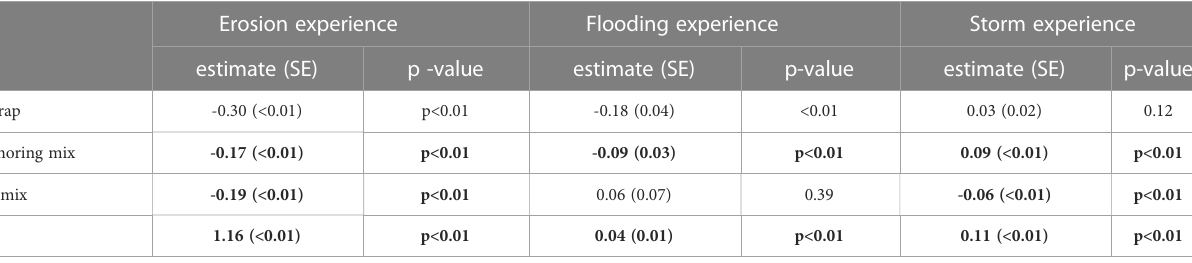
TABLE 7 Marginal effect estimates of property owner experience.